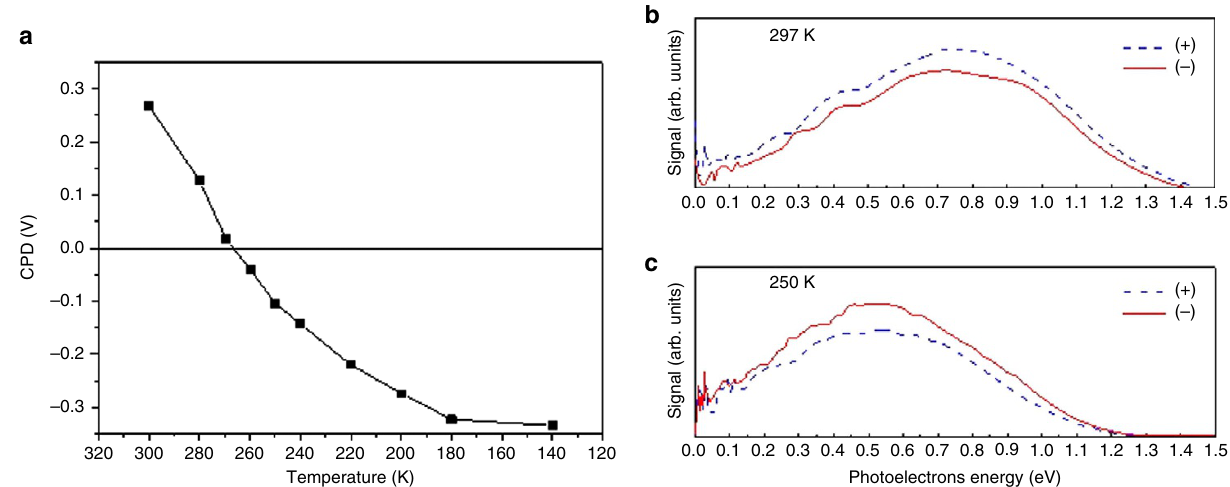
Figure 1 | Temperature-dependent contact potential (surface work function) and spin-polarized photoemission. ( a ) Temperature- dependent contact potential difference (CPD) measurement of gold coated with a self-assembled monolayer of L-polyalanine, bound to the surface through the carbon terminal. Zero voltage indicates the CPD of the bare gold. ( b , c ) Energy distribution of photoelectrons ejected from the gold substrate using a 248nm laser with clockwise ( þ , blue) or counter clockwise ( (cid:2) , red) circularly polarized light, at temperatures of 297K ( b ) or 250K ( c ). Adapted from ref. 5, used with